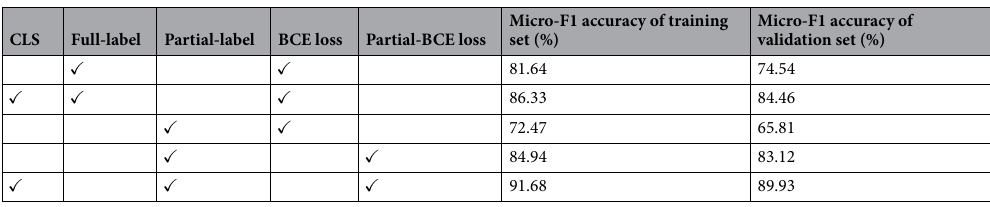
Table 3. Ablation study of the proposed method.